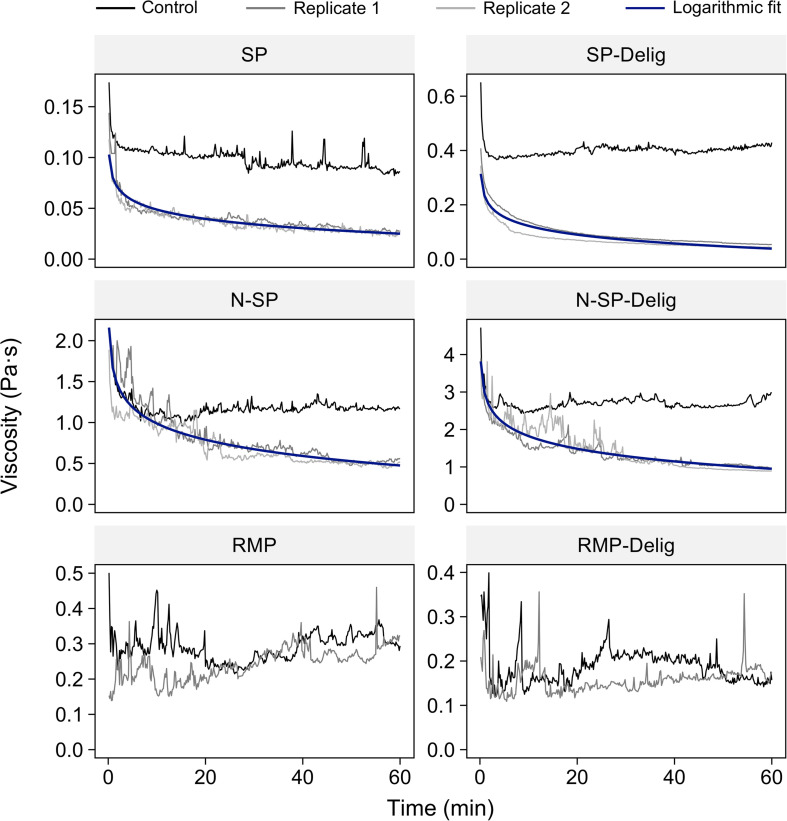
In-rheometer assessment of pretreated aspen substrates hydrolyzed by Cellic CTec3 at 20 mgprotein gcellulose–1. For visual clarity, only one replicate is shown for the RMP and RMP-Delig substrates.